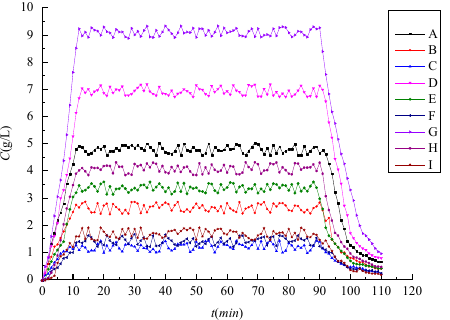
Figure 10. Diagram showing changes over time with a control system.